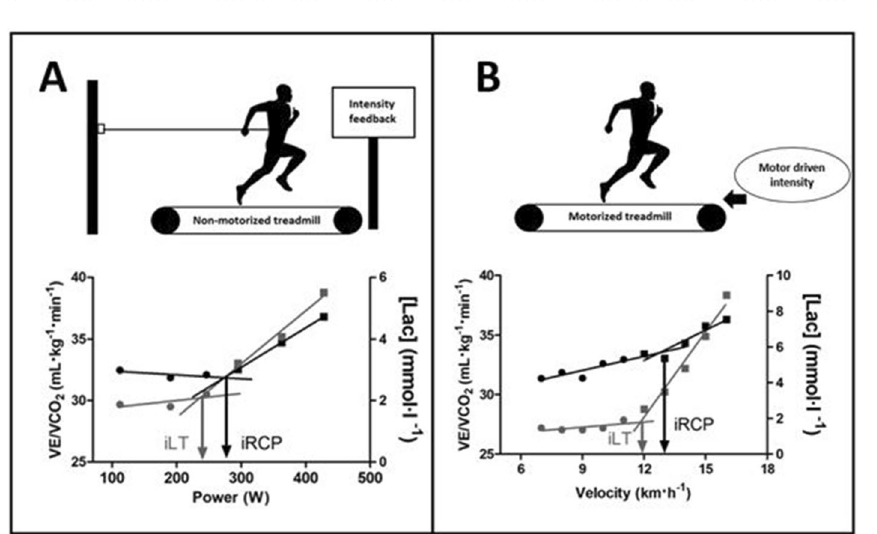
Figure 2. Example of the nonmotorized treadmill ( A ) and motorized treadmill ( B ) set up to determine iRCP and iLT; power is expressed as the resultant of horizontal and vertical orientations. Arrows are merely indicative. ˙ V ˙ V ̇ CO [Lac] blood lactate concentration, E/ 2 quotient between ventilation and CO 2